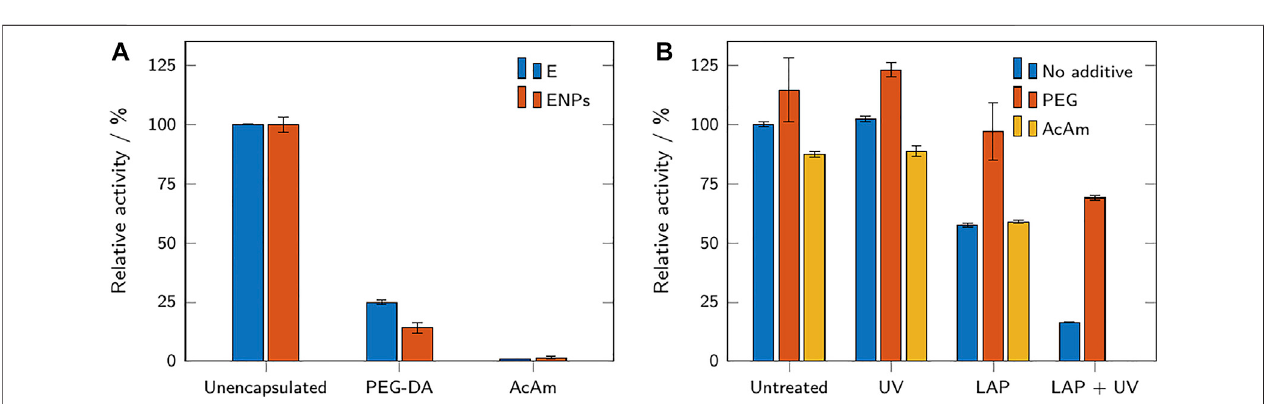
FIGURE 6 | (A) Relative activity of enzymes and ENPs in buffer, compared to PEG-DA and acrylamide-based microparticles containing enzyme and ENPs. The relativeactivitiesrefertotherespectivefree(notencapsulated) samples. (B) Relativeactivityoffreeenzymewithandwithoutadditivesafterexposuretothephotoinitiator LAP and UV light. The relative activities refer to the untreated sample without additive. All results are shown as mean values ± standard deviation ( n (cid:1) 3).